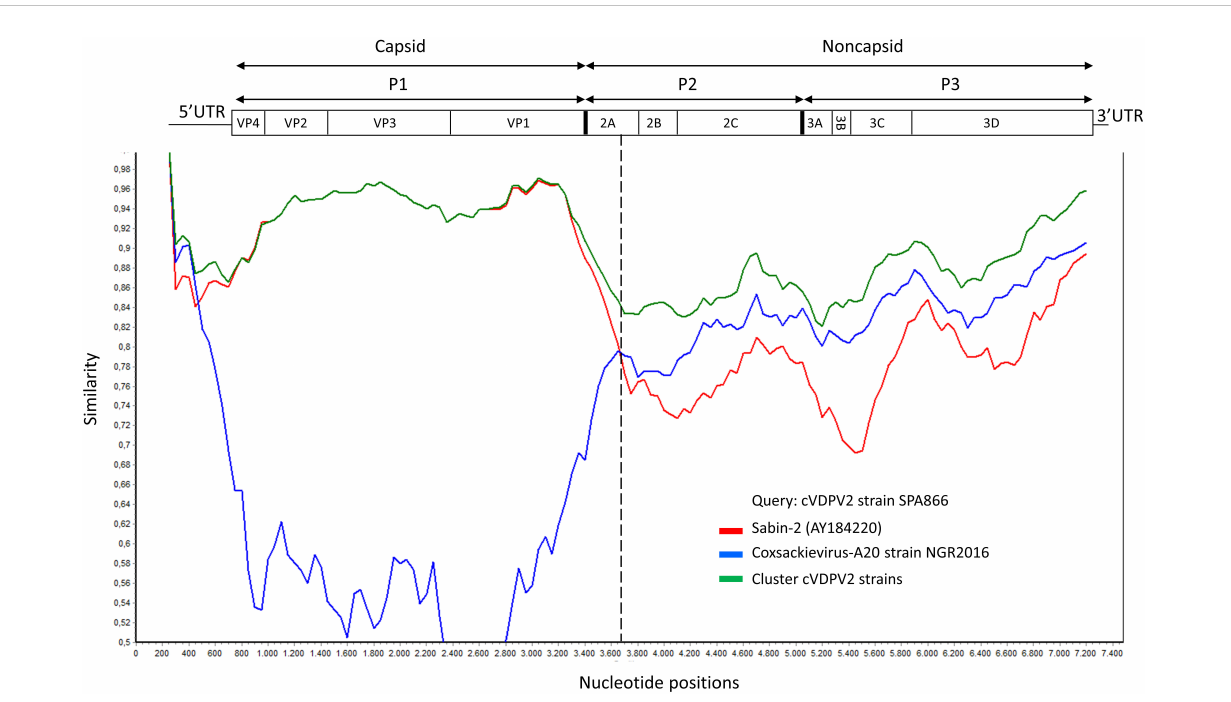
FIGURE 1 Plot of similarity of whole-genome nucleotide sequences of study strain SPA866 (query), Sabin-2 poliovirus strain, and closely related strains from NCBI. The enterovirus genetic organization is shown in the top panel. The breakpoint position of recombination is marked with a dashed line. cVDPV2 strains: MT432140, MG212462, JX275032, JX275140, JX275015, KJ170572, MG212459, KX162700, KX162714, KX162716, MG212490, MG212480, and MT432143; Coxsackievirus-A20 strain NGR2016: MH785183. cVDPV, type 2 circulating vaccine-derived poliovirus; UTR, untranslated region.